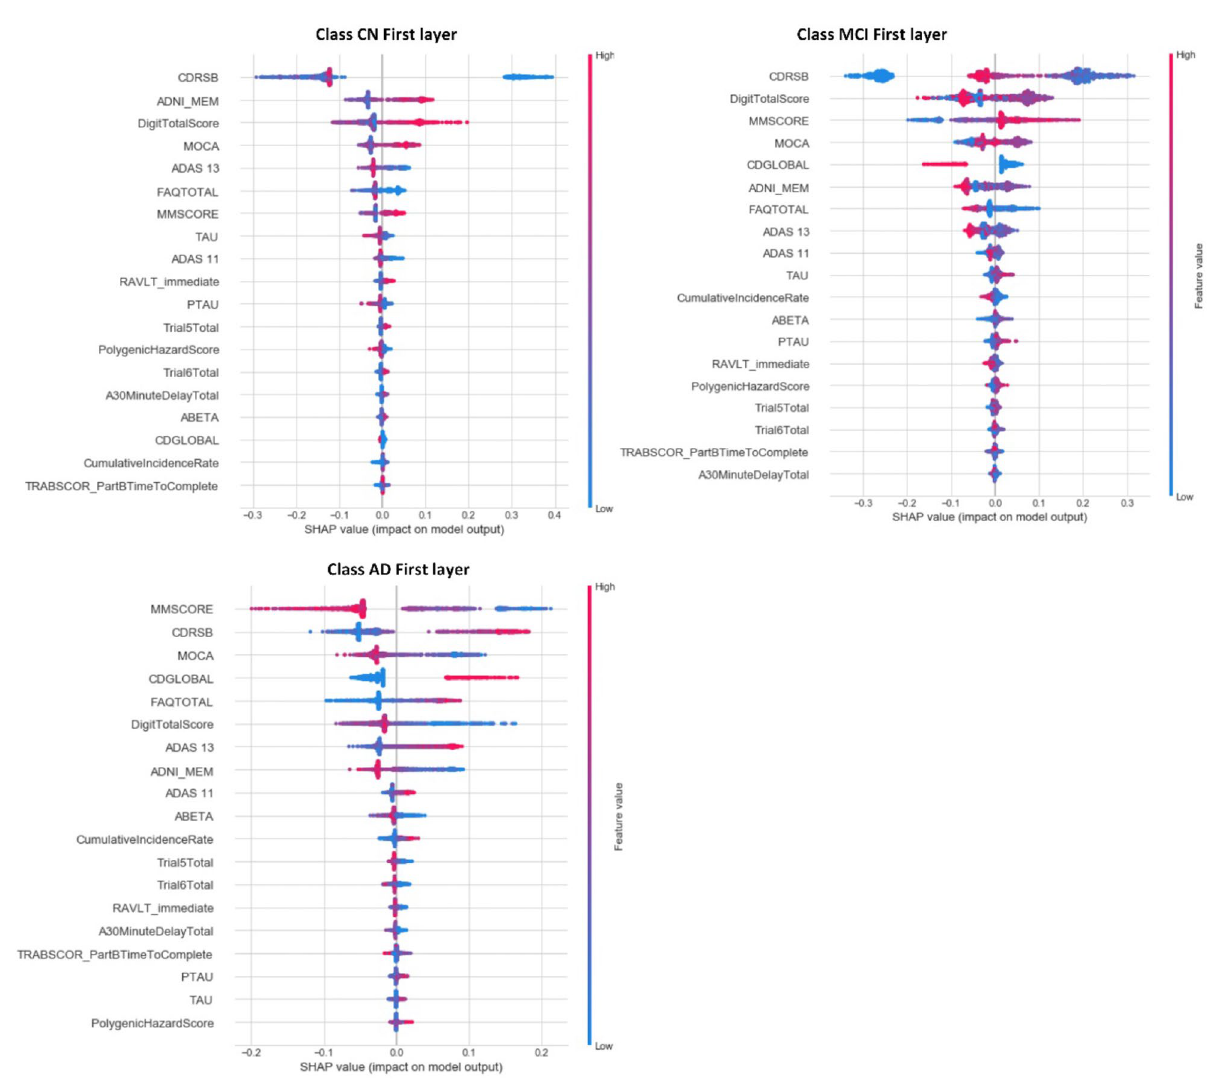
Figure 2. SHAP summary plots for the first layer. The upper left figure represents the CN class, the upper right figure represents the MCI class, and the second row represents the AD